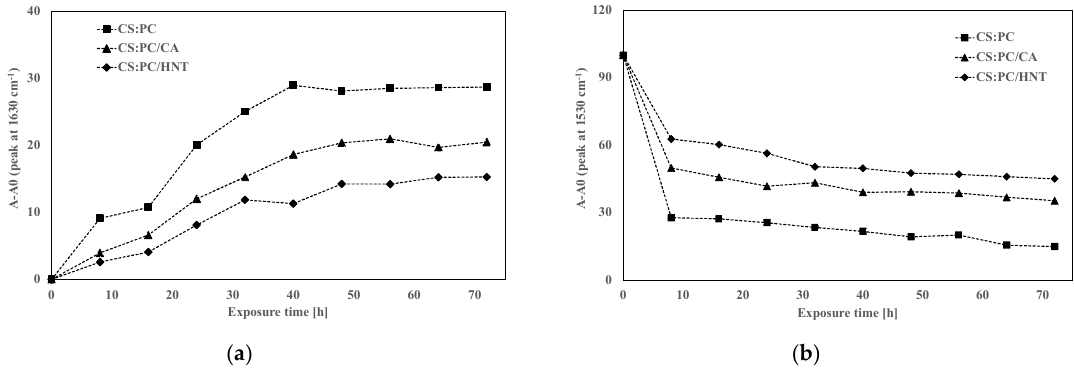
Figure 6. Variation of ( a ) >C=O (~1630 cm −1 ) and ( b ) NH bending (~1530 cm −1 ) for CS:PC, CS:PC/CA and CS:PC/ HNT